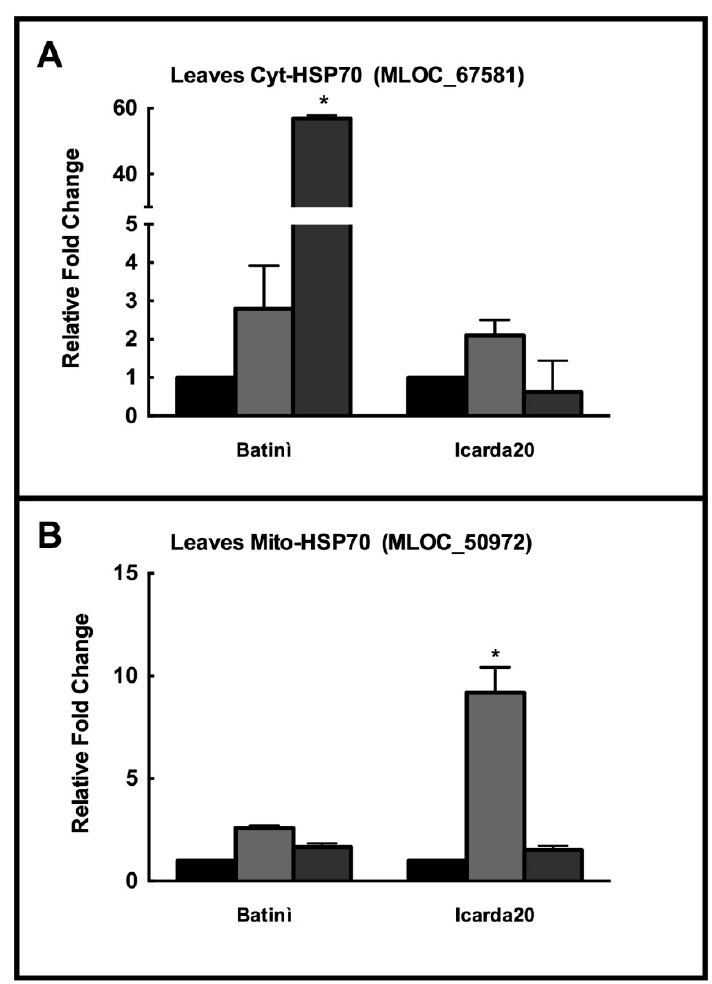
Figure 7. ( A ) The changes in the expression of Cyt-HSP70 (MLOC_67581) (abiotic stress responsive); and ( B ) Mito-HSP70 (MLOC_50972) (biotic stress responsive), in leaves of barley plants cv. Batinì and ICARDA 20 collected after 3 days upon control (Black bars), salt stress (NaCl 150 mM—light grey bars) and drought (PEG 10%—dark grey bars). The asterisks (*) indicate p value ≤ 0.001.